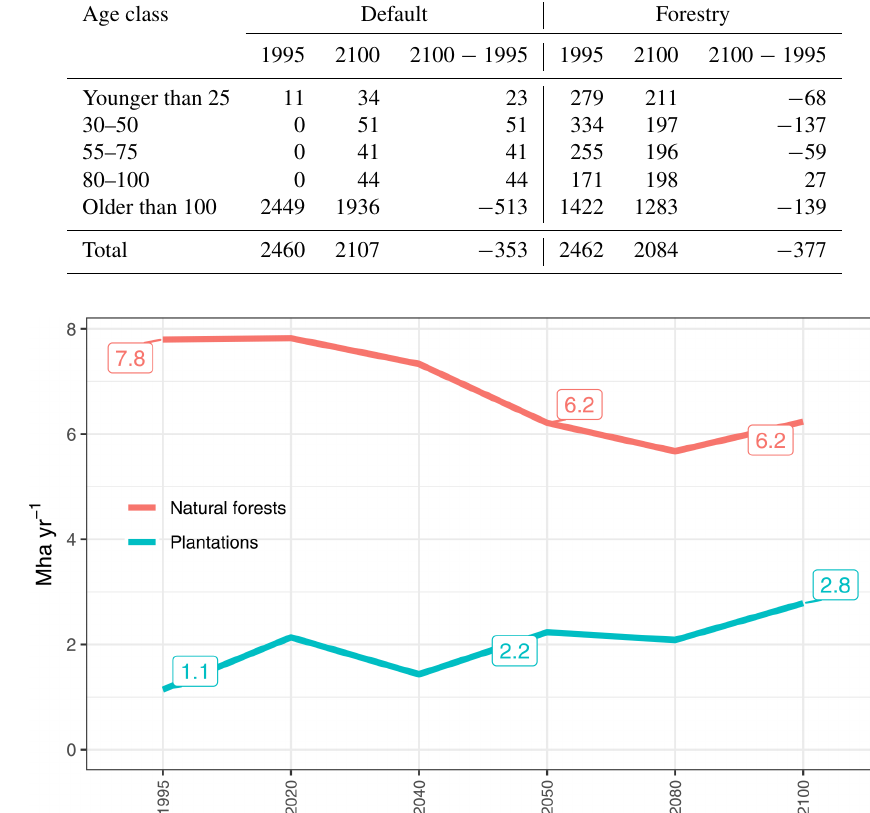
the global level, the spatial cropland patterns differ substan- tially between the two scenarios, which indicates that tim- ber plantations compete with cropland for the same scarce land resources. The net effect is a stronger decline in nat- ural forest in the forestry scenario compared with the de- fault scenario. New timber plantations might be partly es- tablished on cleared natural forests; however, considering the substantial changes in spatial cropland patterns, it seems likely that plantations are also established on cropland and pasture land, which causes deforestation for cropland expan- sion